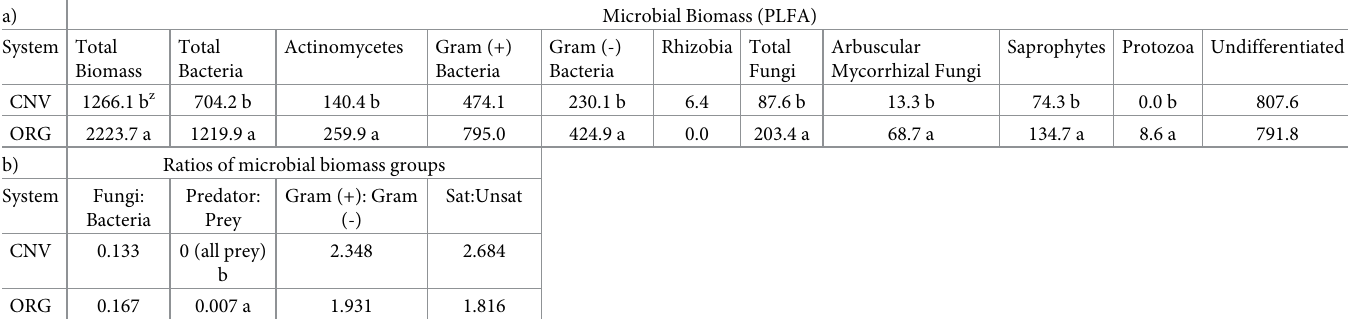
Table 3. Biomass of microbial groups in soils managed using organic and conventional management just prior to planting during summer 2014 at Purdue’s Meigs Horticulture Research